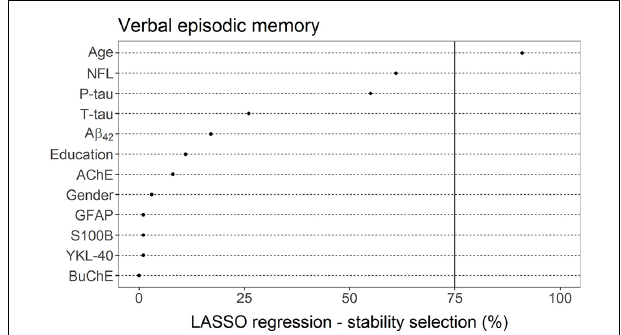
FIGURE 7 | LASSO linear regression—stability selection analysis for the identification of a set of variables predicting verbal episodic memory performance. The cut-off selection value was set at 75% and the per-family error rate (PFER) at 1. Variables selected into the model at least 75% of the time were considered reliable predictors. Only age reached that